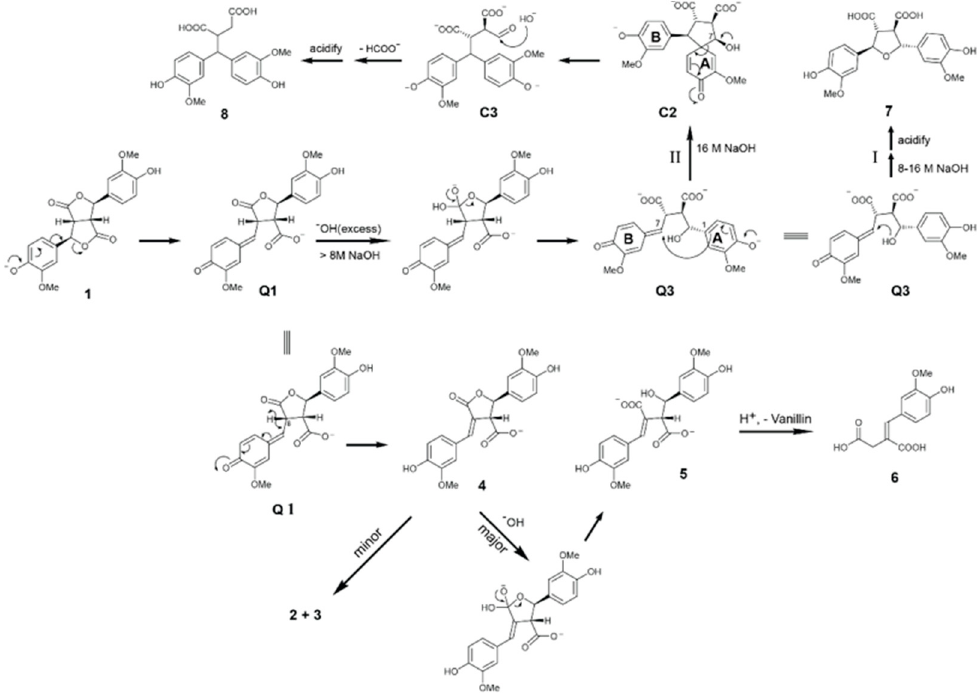
Figure 5. The proposed mechanisms leading to the formation of products from FA dilactone in aqueous NaOH solution followed by acidification. Note: all compounds are racemic although one isomer is drawn.